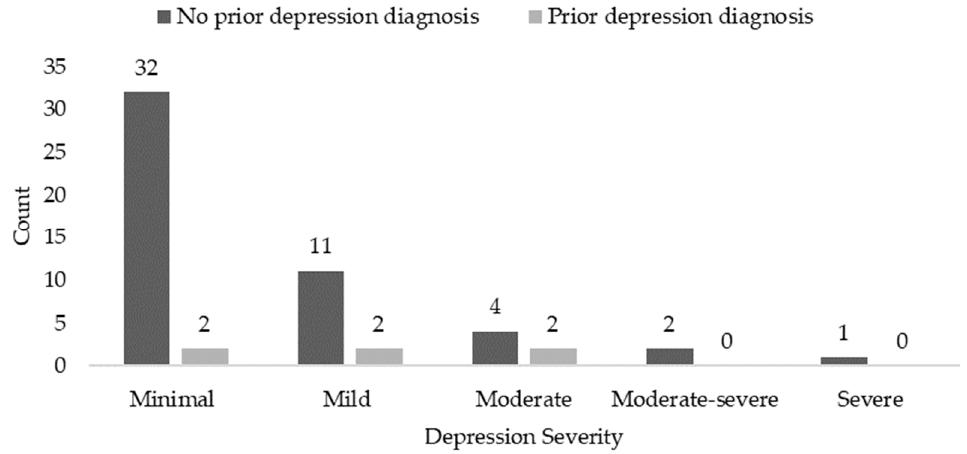
Figure 2. Patient health questionnaire 9 (PHQ-9) depression screen by prior depression